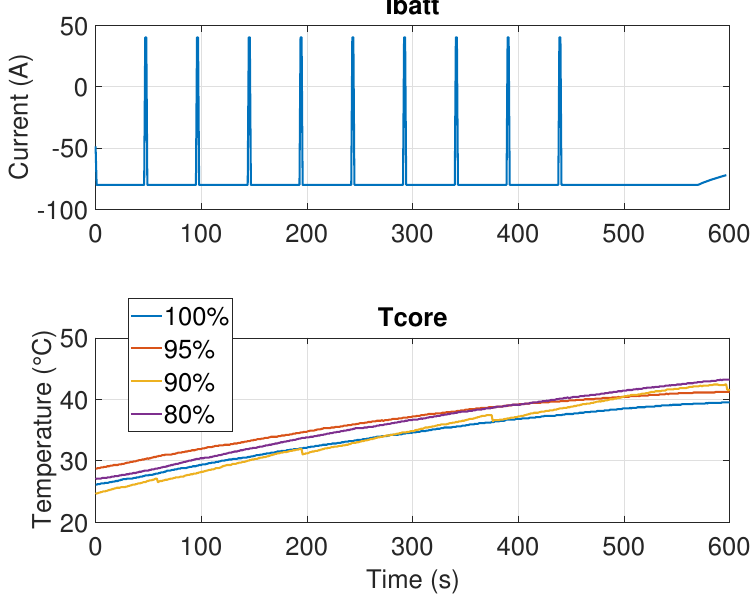
Figure 8. Graph of the temperature evolutions for all aging states as well as the CCNP–CV profile used in the